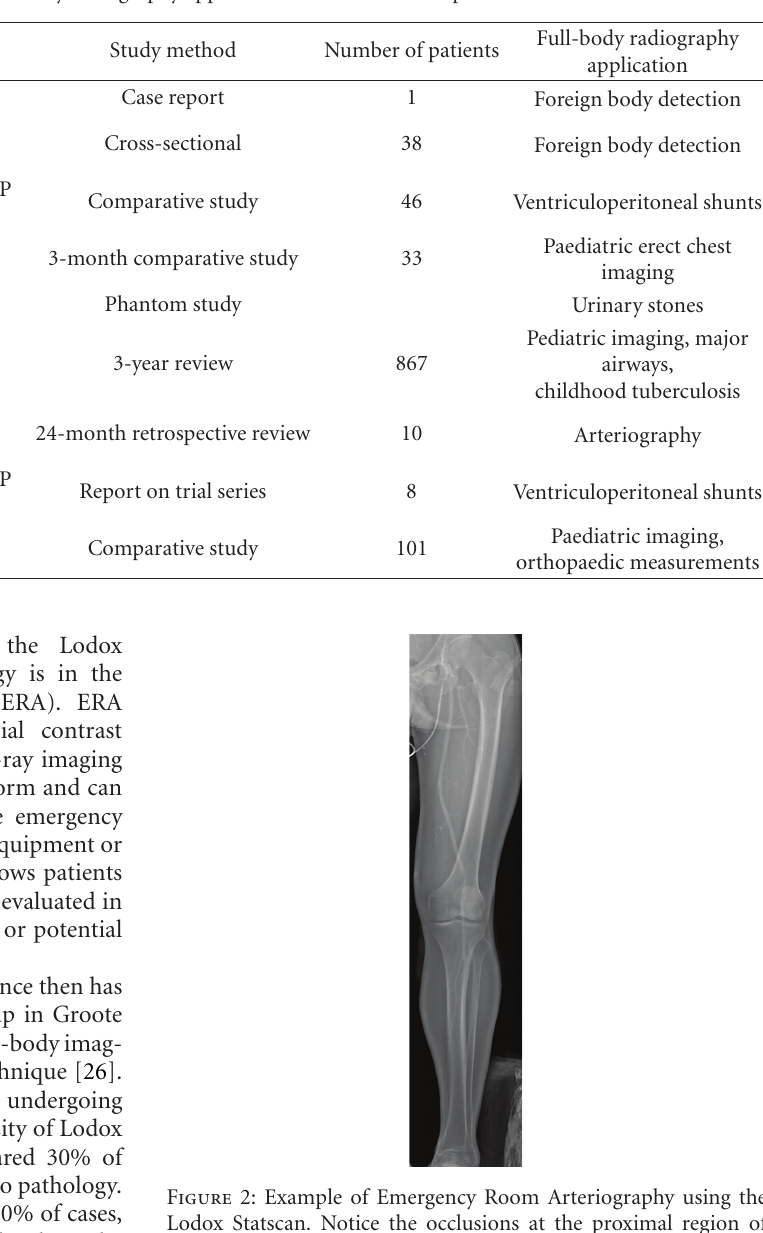
Table 1: Publications of full-body radiography applications to nontraumatic patients.